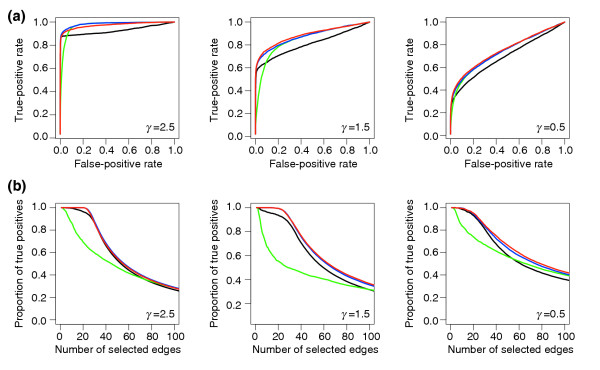
Performance of different GGM approaches. (a) ROC curves and (b) the proportion of true-positive edges as a function of the number of selected edges for the different graphical modeling strategies. Black line, the standard GGM; red line, frequentist modified GGM approach; blue line, latent random graph modified GGM approach; green line, pairwise correlation. Sparse networks with fewer edges as nodes (γ = 2.5) are represented in the left column, networks with approximately as many edges as nodes (γ = 1.5) are represented in the middle column, and networks with approximately twice as many edges as nodes (γ = 0.5) are in the right column.